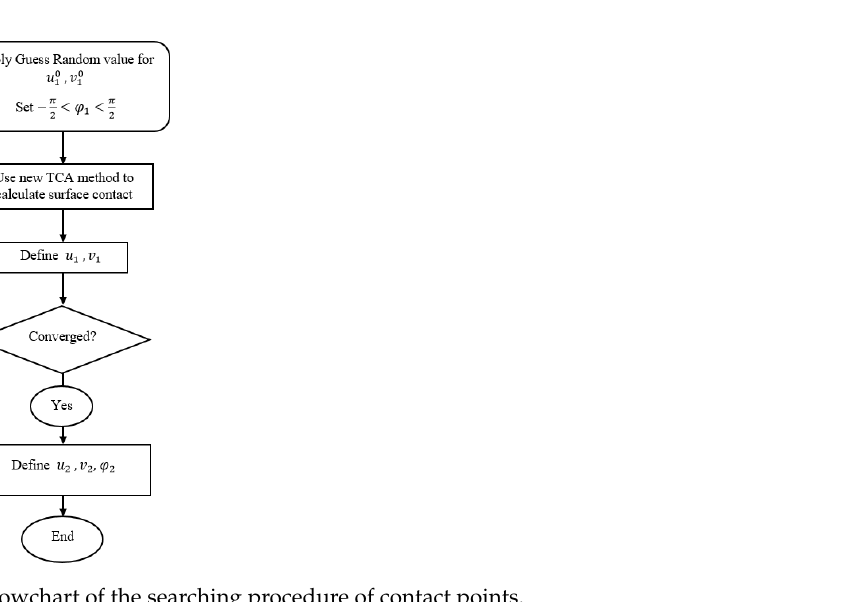
Figure 3. Flowchart of the searching procedure of contact points.